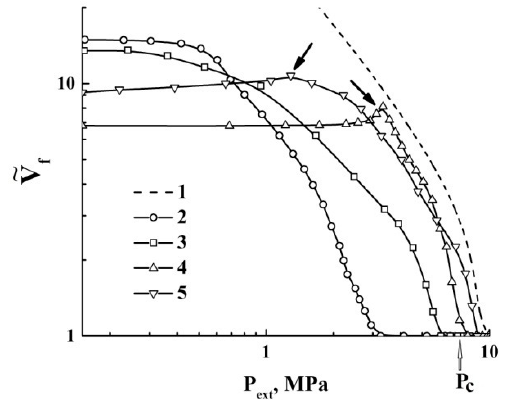
V P  for the polylactide foams.   0 f ext